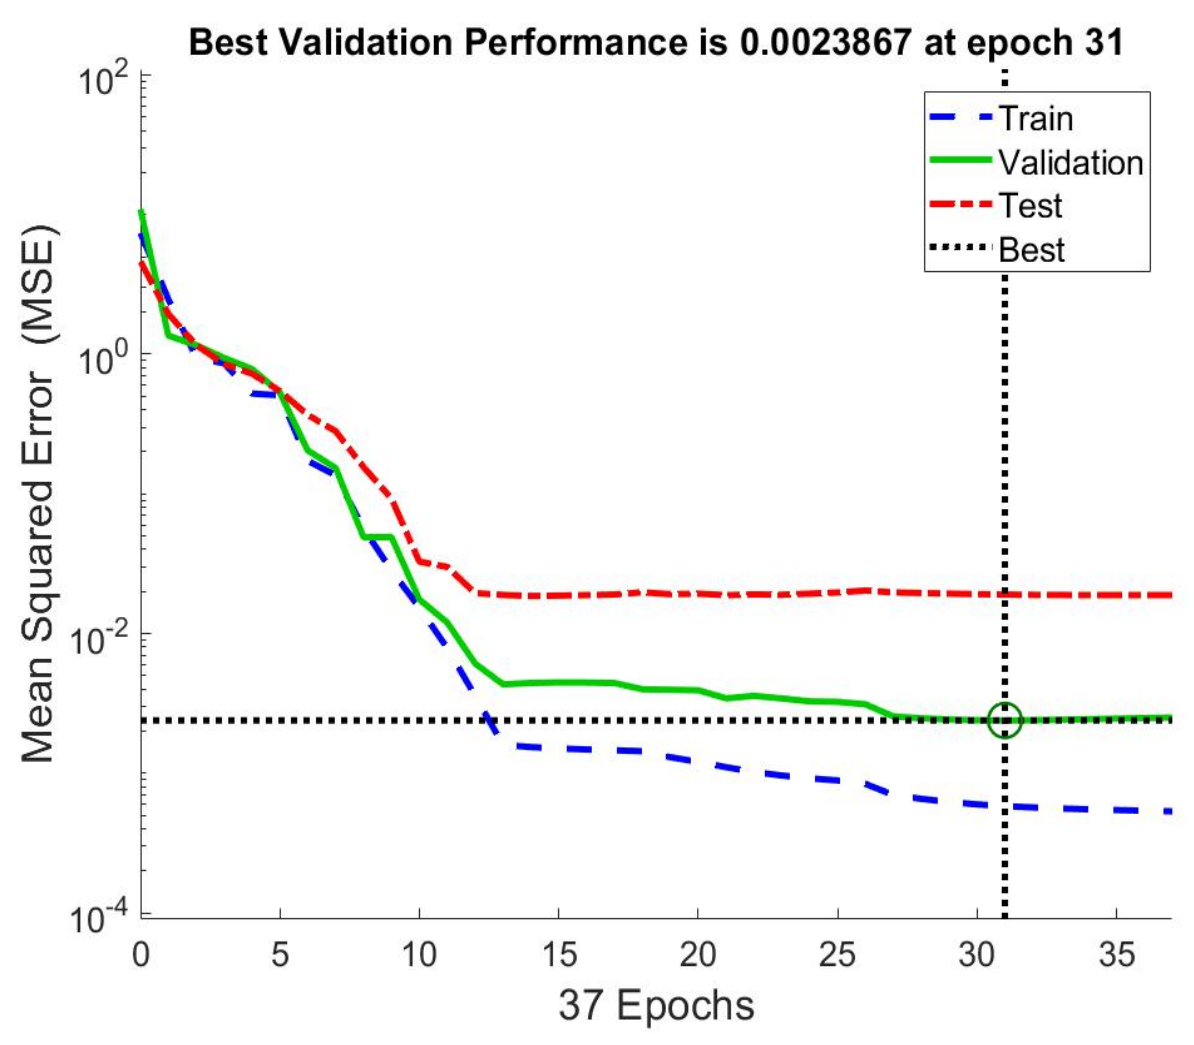
Figure 5. MLP neural network training performance.